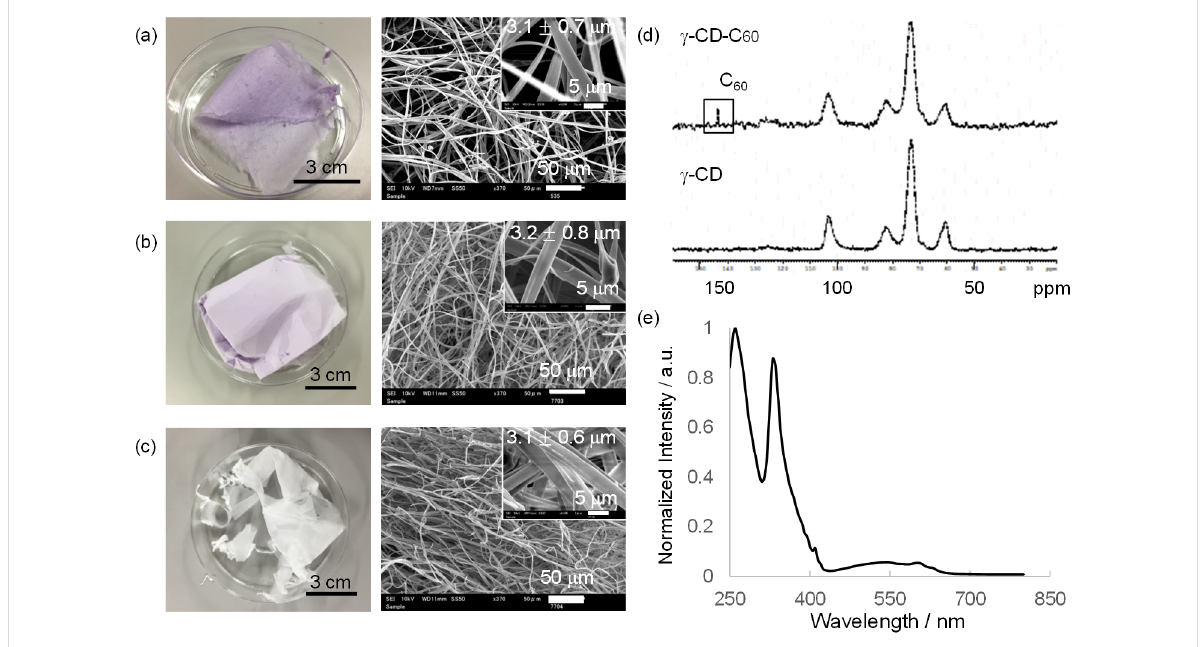
Figure 3: Fabrication of γ -CD–C 60 inclusion complex nonwovens by electrospinning. Photographs and SEM images of (a) γ -CD–C 60 nonwoven